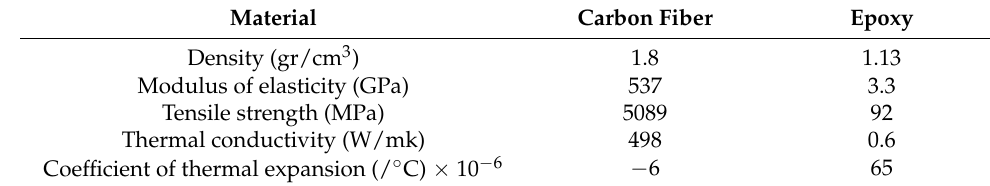
Figure 1. Carbon-fiber-reinforced polymer (CFRP) composites: ( a ) VARIM method and ( b ) fabricated CFRP plate. Table 1. Mechanical and physical properties of used materials as components in the composite